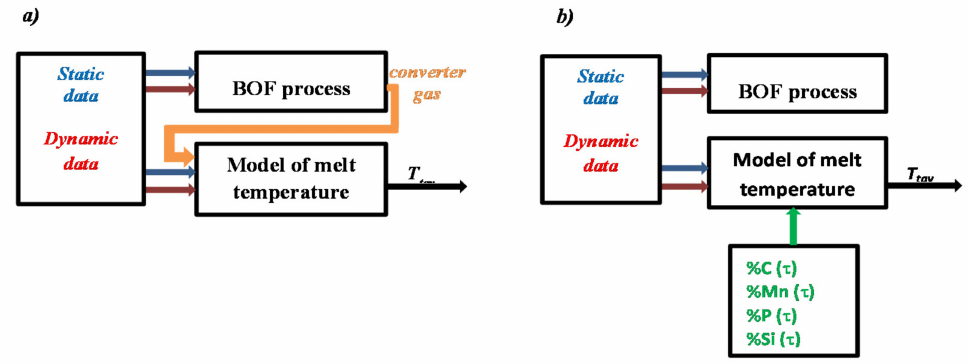
Figure 4. The principle scheme of deterministic models ( a ) model with feedback, ( b ) model without